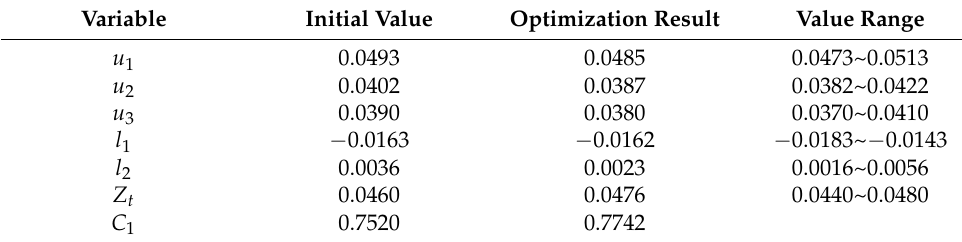
Table 9. Optimization results of airfoil 3 under condition C.